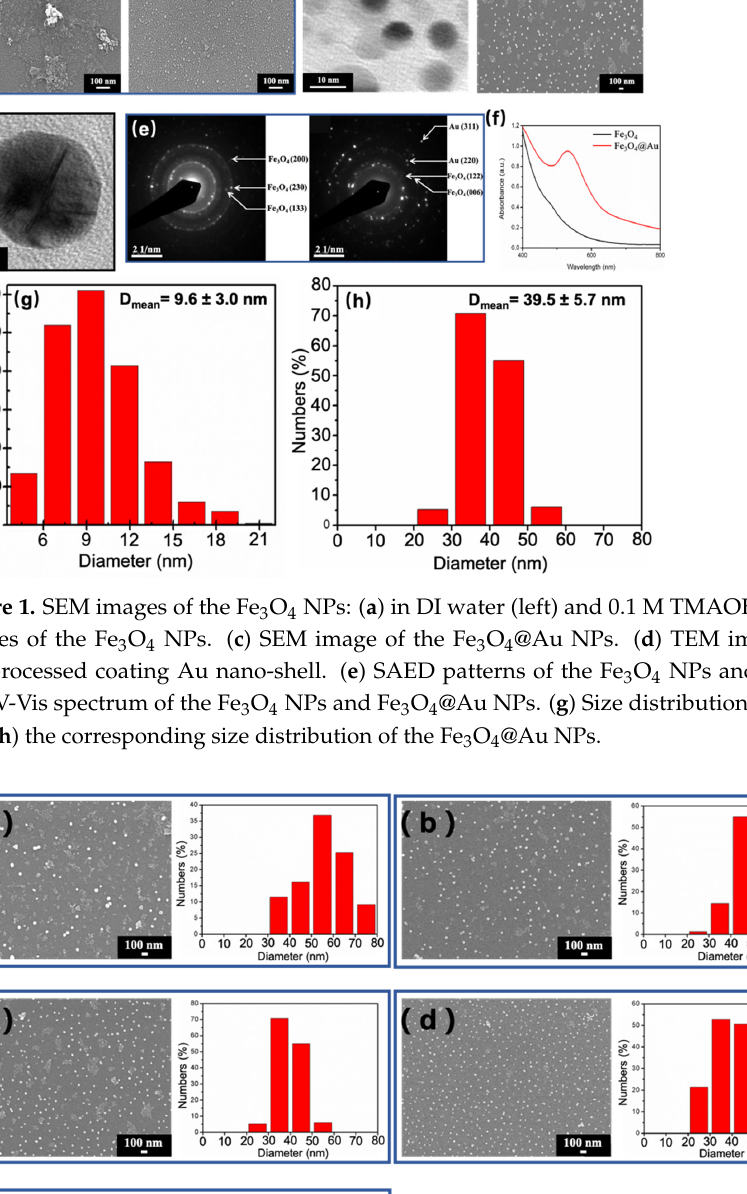
Figure 3. ( a ) UV-Vis spectra of different Fe 3 O 4 @Au NP sizes, the inset shows the difference of absorbance peak among each size of nanoparticles. ( b ) XRD patterns of different Fe 3 O 4 @Au NPs and Fe 3 O 4 NPs size distributions. ( c ) Magnetic